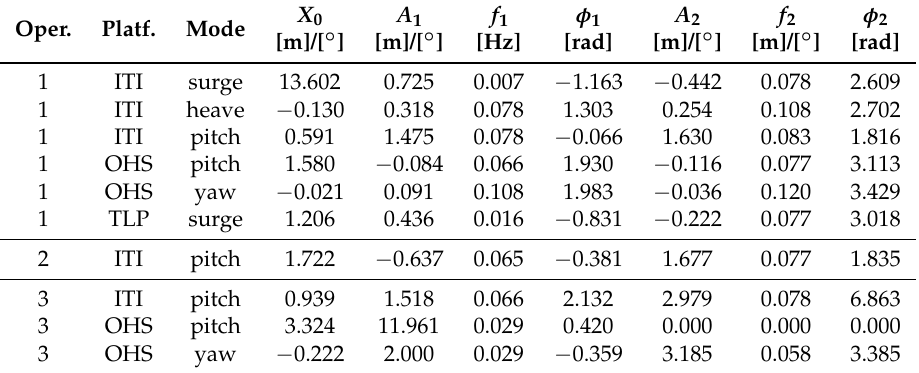
Table 3. Parameters of platform motions [5] for the NREL 5 MW turbine with different floater types. Oper.